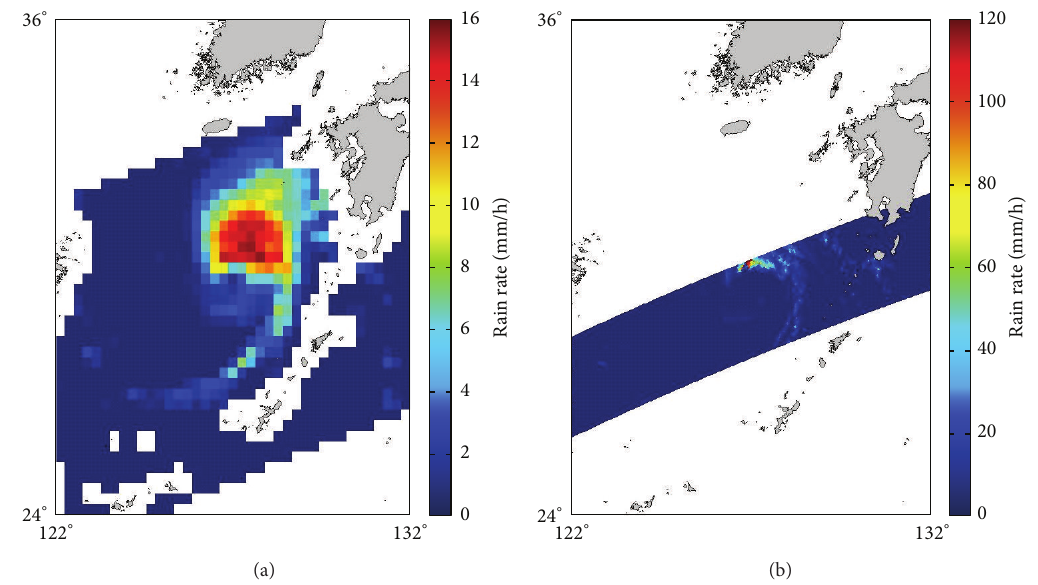
Figure 8: TRMM rain rate fields (mm/h) for the typhoon Danas on 7 October 2013 ∼ 18:40 UTC: (a) TMI RR product from Remote Sensing Systems and (b) PR RR product from NASA/Goddard Space Flight